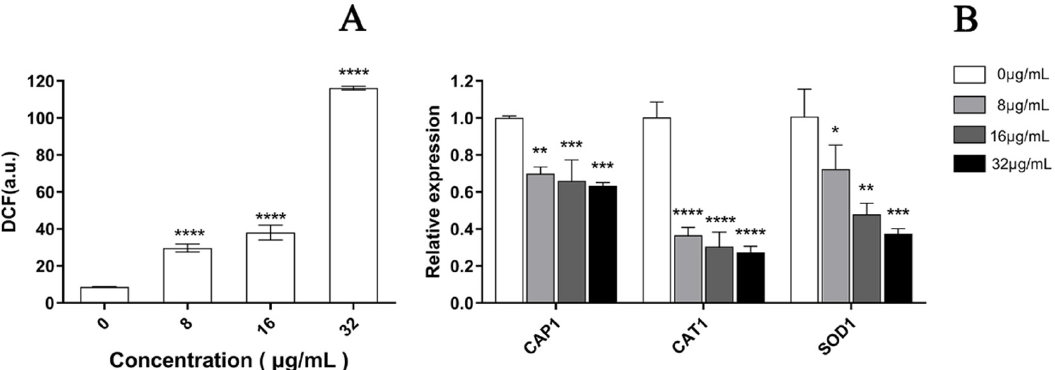
the untreated controls. Scale bars represent 100 μ m.